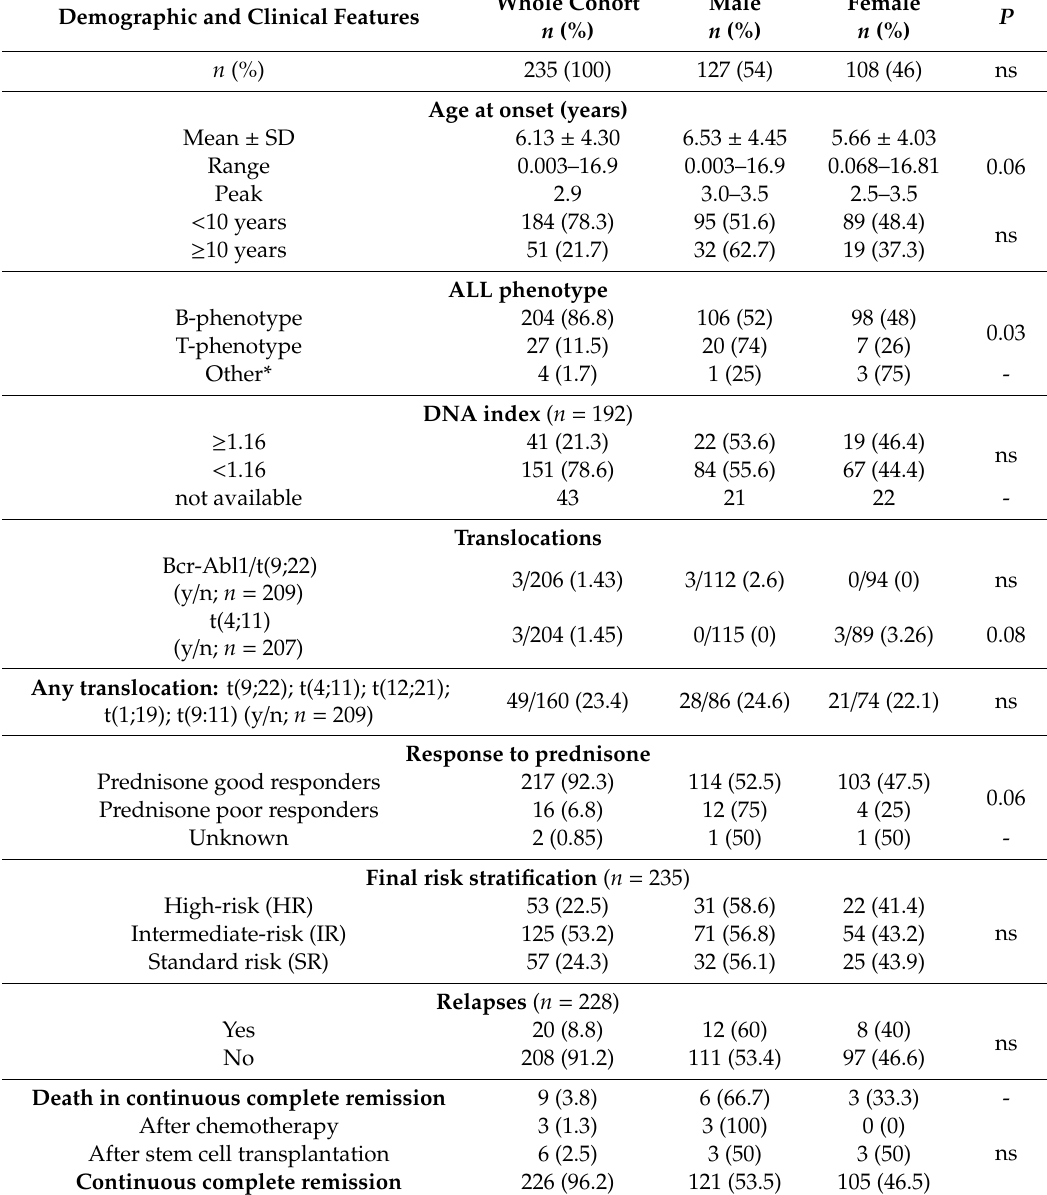
Table 1. Demographic and clinical features of patients stratified by